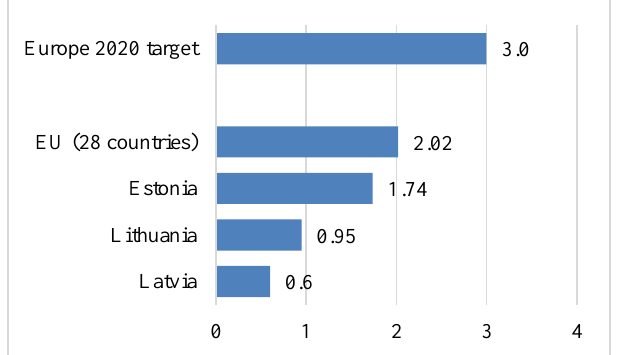
Fig. 4. Situation of countries with regard to its R&D intensity target (the author’s chart based on the data of